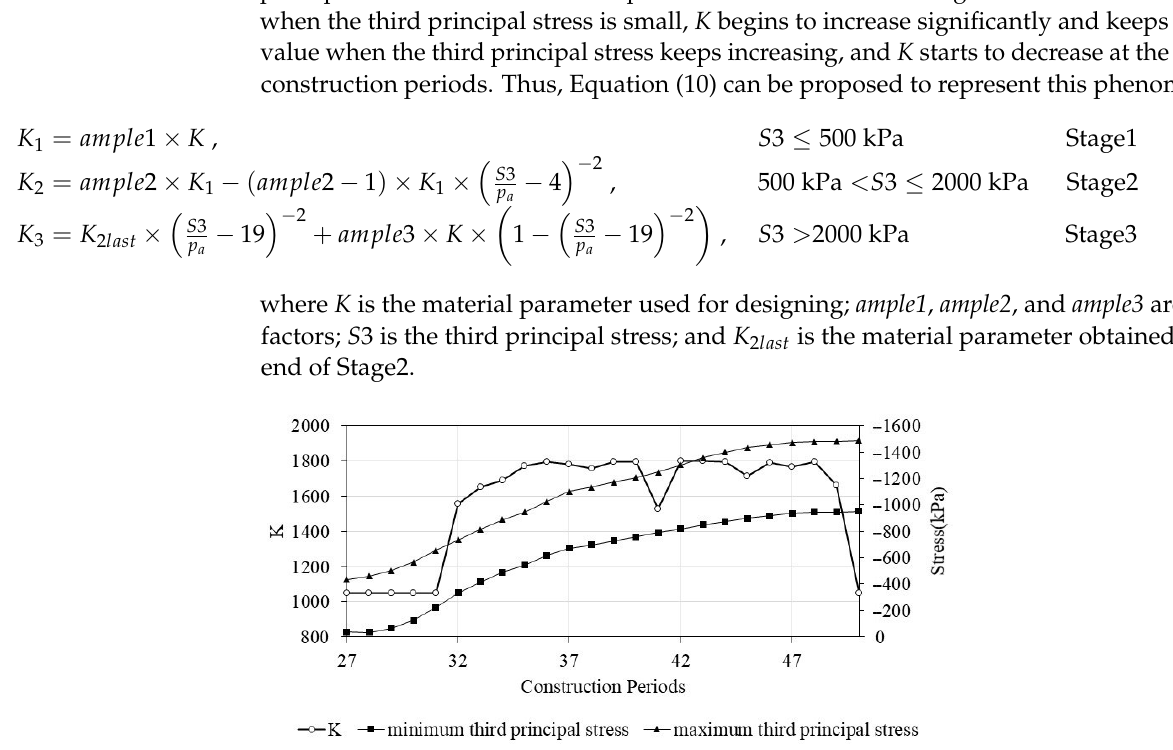
Figure 9. The trend diagram of K and the third principal stress with construction periods.